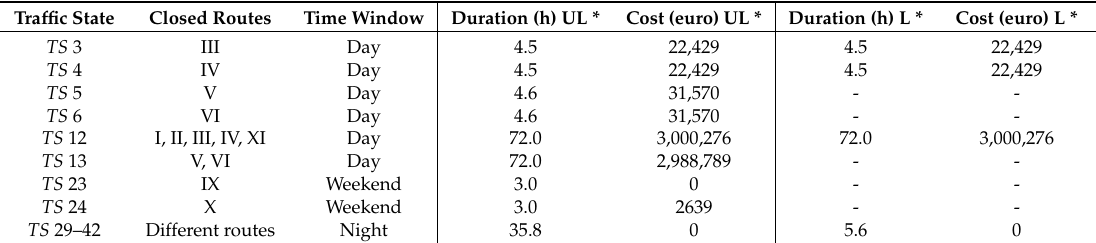
Table 9. Traffic states of the intervention program developed with the network flow